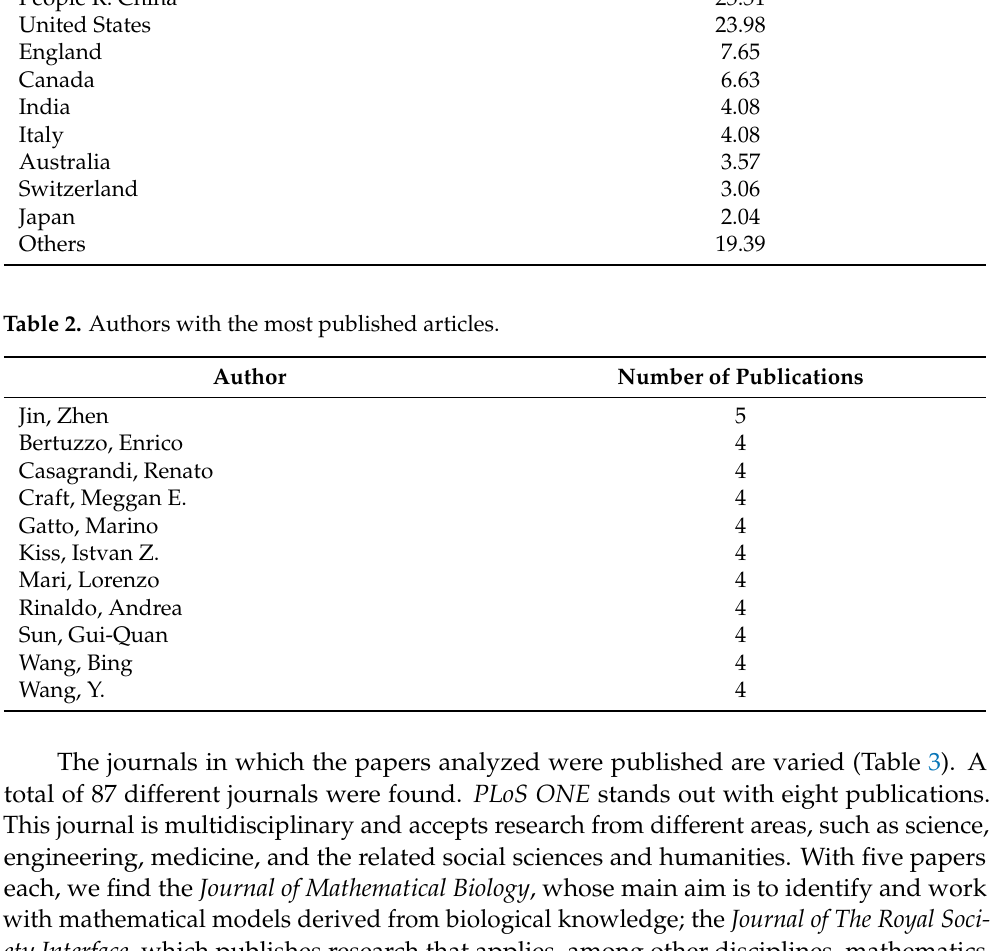
Table 1. Countries of the authors of the publications. Countries